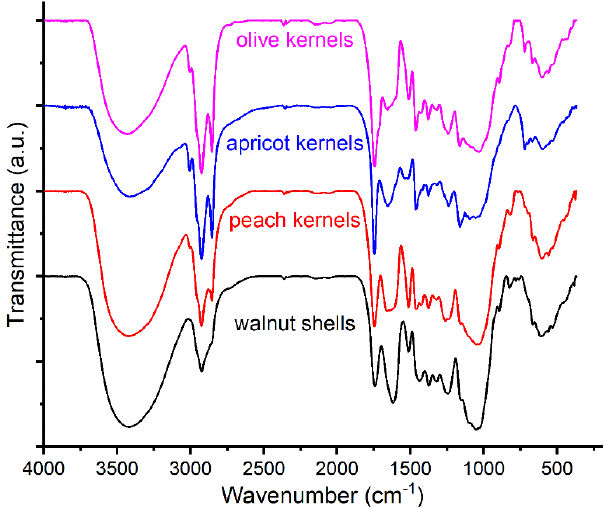
Figure 3. FTIR spectra of walnut shells and kernels of peach, apricot, and olive.